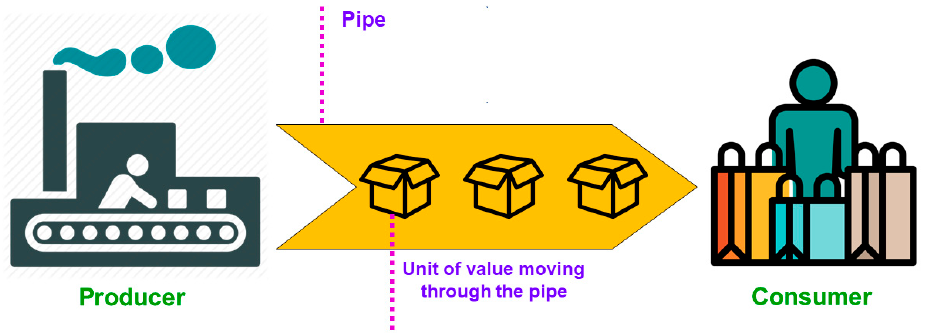
Figure 1. The pipeline business